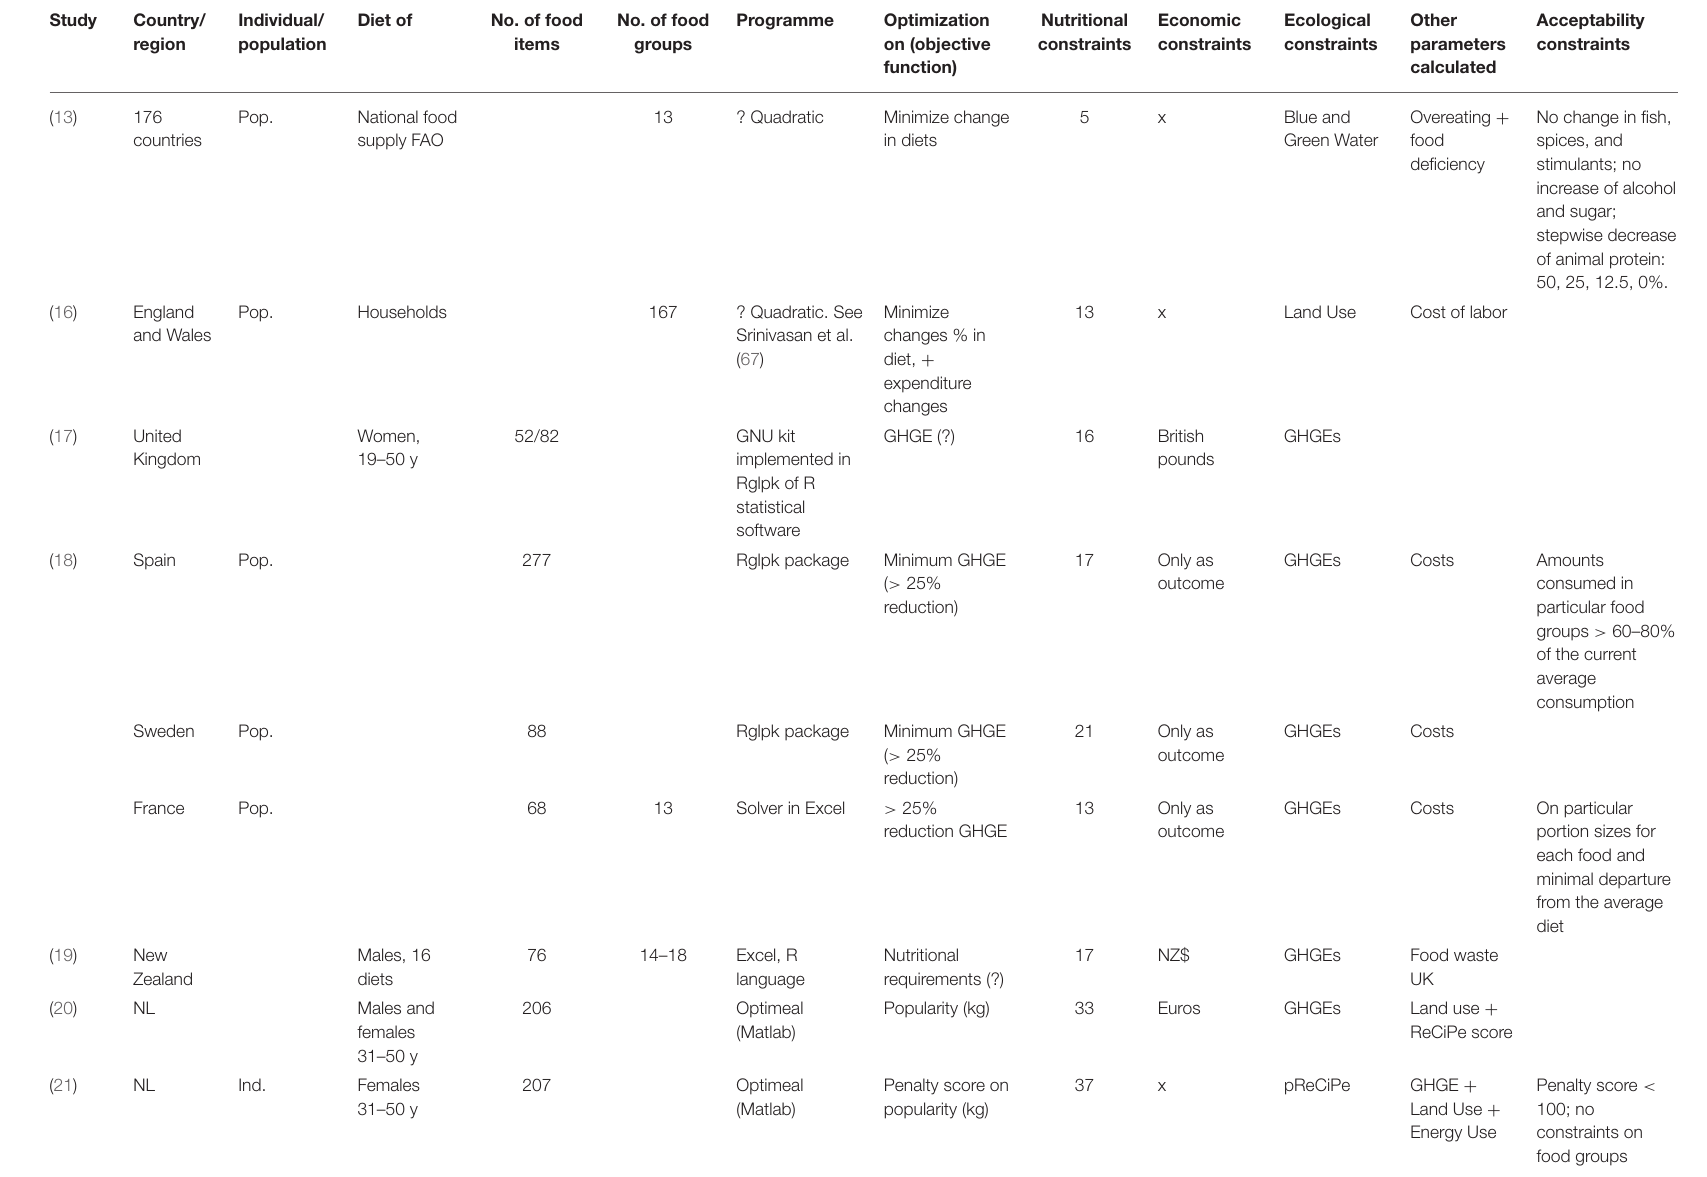
TABLE 2 | Twelve diet studies with nutritional and ecological constraints. Study Country/ Individual/ Diet region population